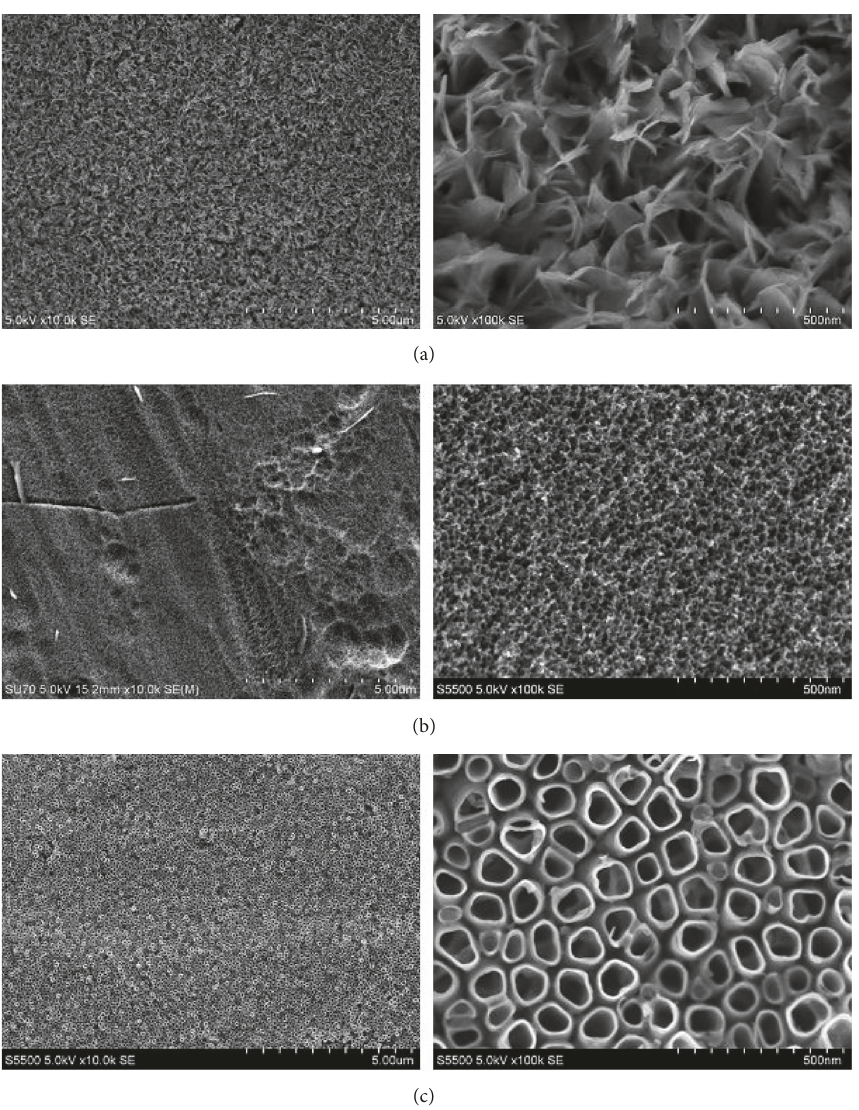
Figure 3: SEM images of chemicallytreatedTi in (a)NaOH,(b) H 3 PO 4 + H 2 O 2 solution, and(c)electrochemicallytreatedin NH 4 F + glycerol + water electrolyte (20V for 2h)